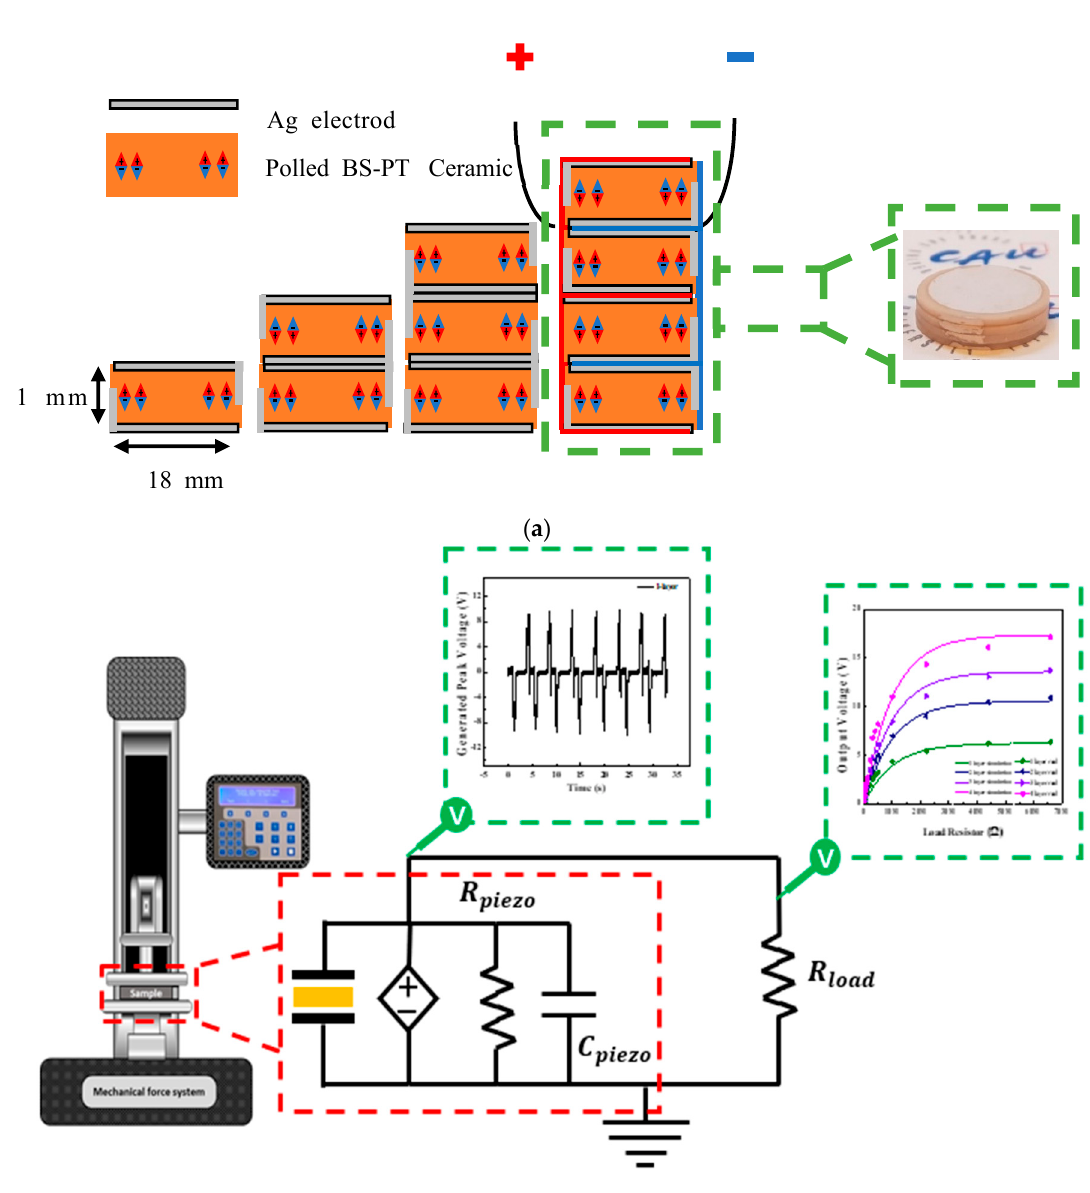
Figure 5. ( a ) Schematic of the 1–4 layer structured piezoelectric energy harvesters based on BS-PT multilayered ceramics. ( b ) Equivalent circuit of the piezoelectric energy harvester and the generated voltage measurement system at the load resistor using the mechanical force vibrator.